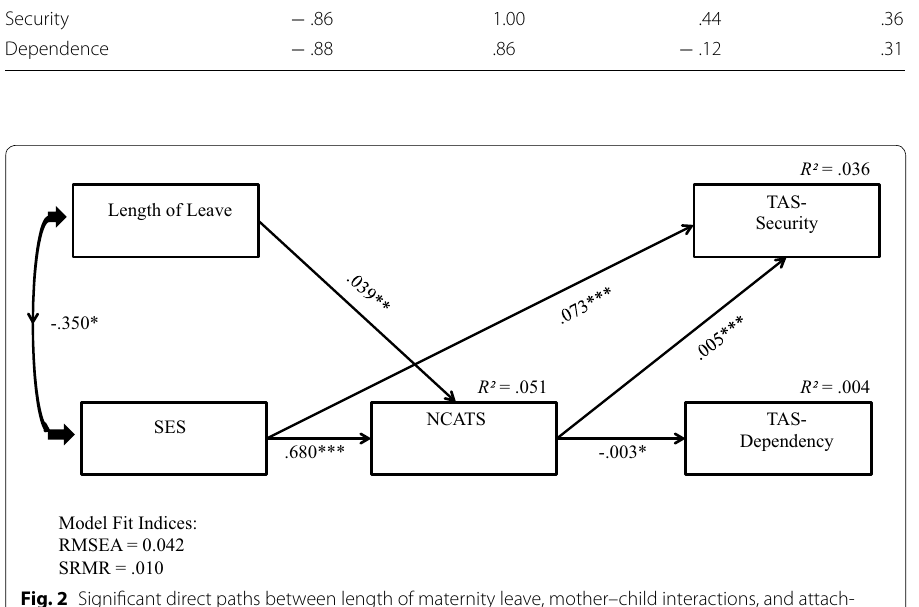
Fig. 2 Significant direct paths between length of maternity leave, mother–child interactions, and attach‑